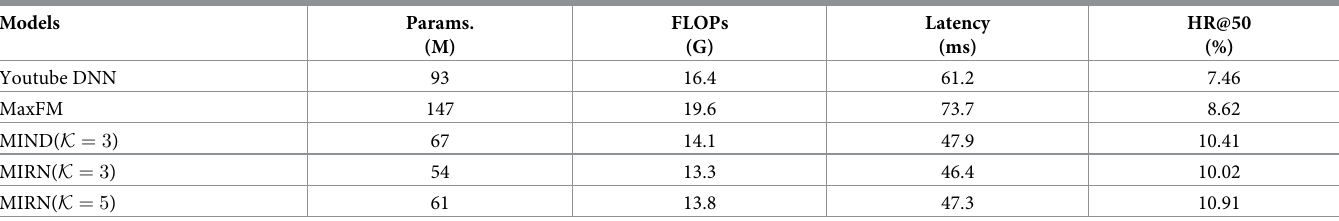
Table 6. Comparison of the speed and accuracy of different dense retrieval models on Amazon Electron. Models Params.